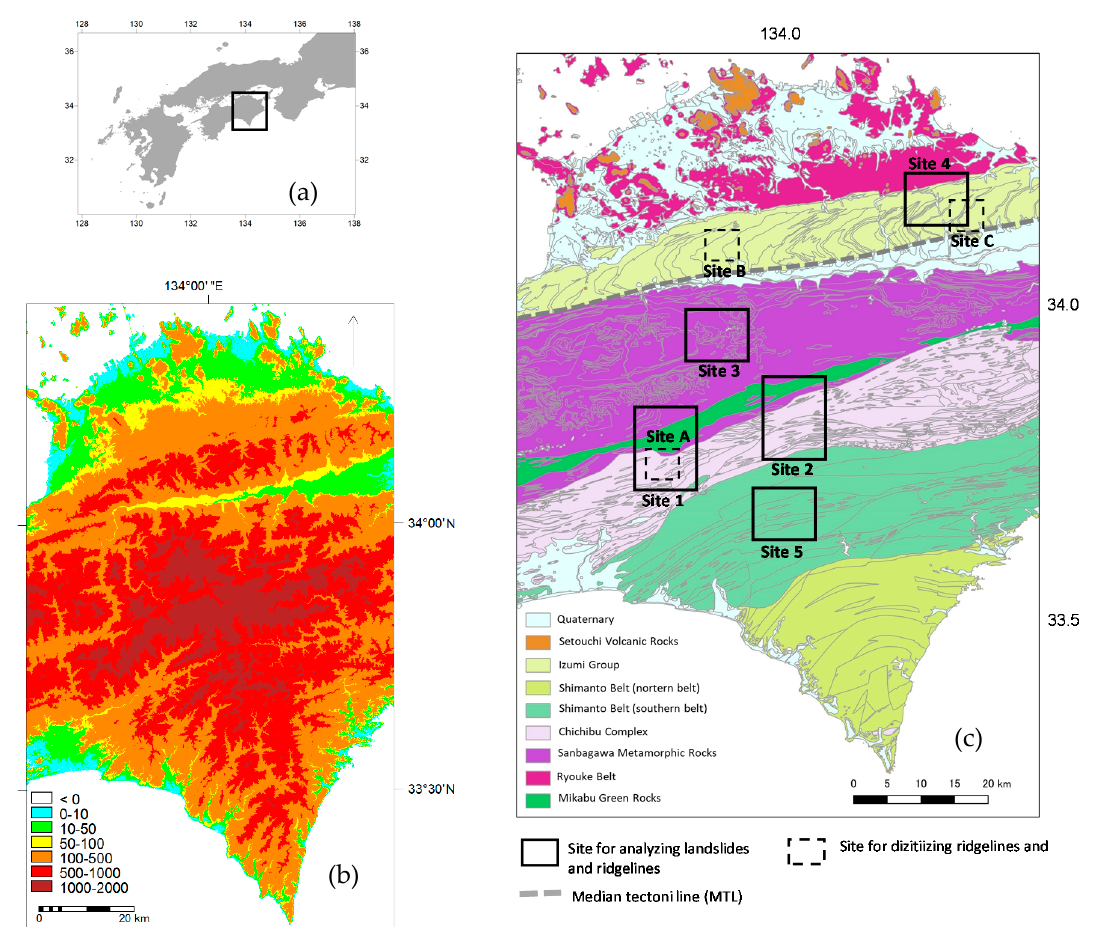
Figure 1. Study area ( a ) Location of the study area (Black square shows the study area) ( b ) Elevation map ( c ) Geological map [17] with the location of sites (Site A-Site C and Site 1-Site 5)